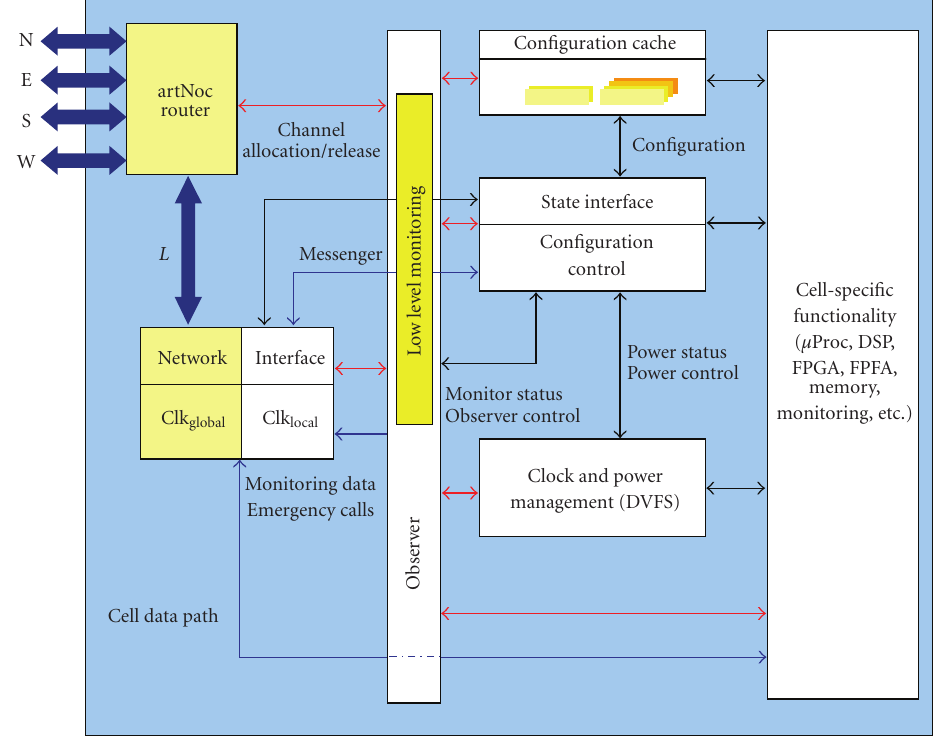
Figure 2: OPC block diagram view.